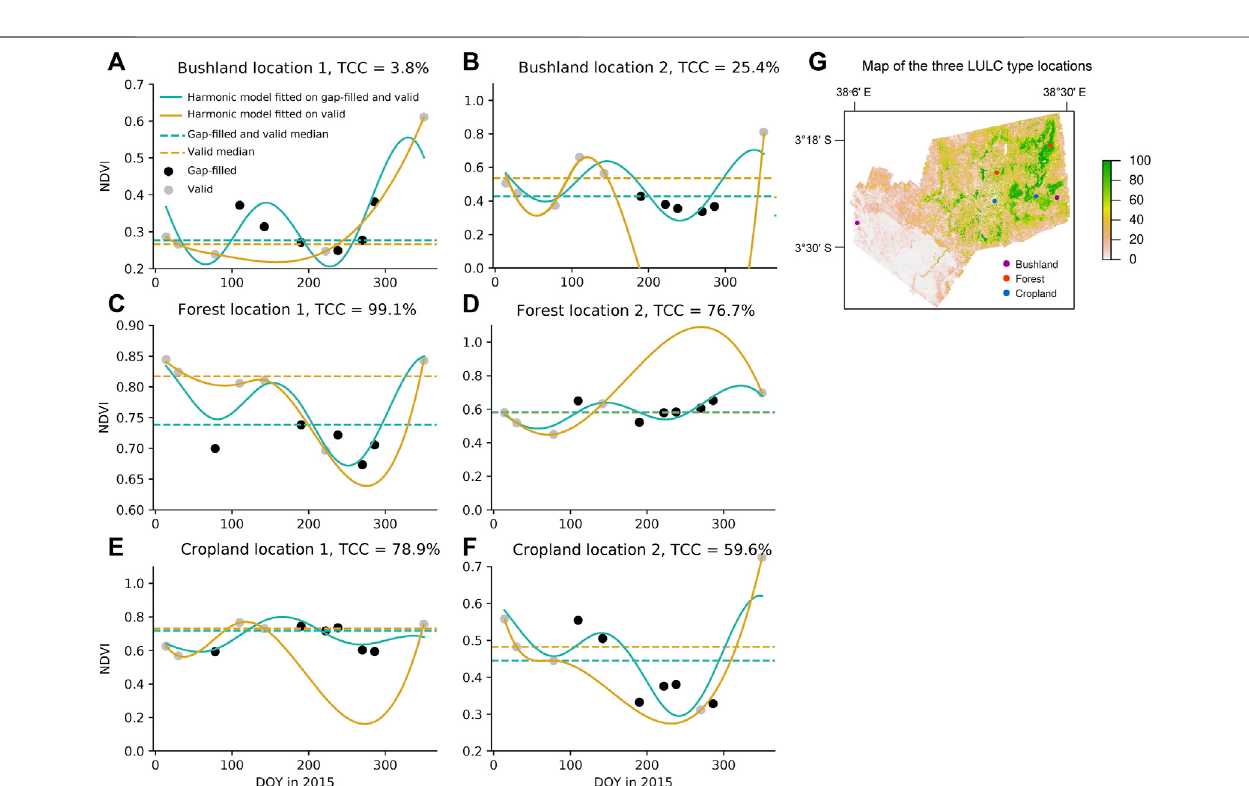
FIGURE 7 | Examples of harmonic curves fi tted by only valid points (yellow lines) and a combination of MOPSTM gap- fi lled and valid points (green lines) for NDVI time series across three different land cover types: (A,B) bushland, (C,D) forest, (E,F) cropland, and (G) TCC map of the three land cover type locations. The corresponding color dashed lines are the median of the annual NDVI values. The grey points show the only valid NDVI values and the black points show the MOPSTM gap- fi lled NDVI values.